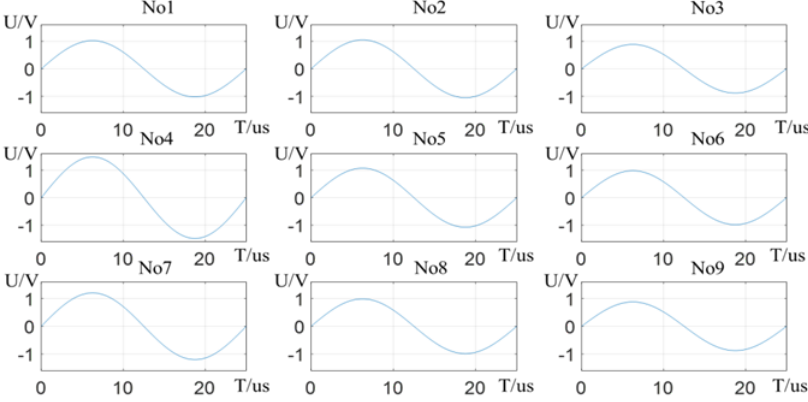
Figure 9. Sensing electrodes potential difference change curve.